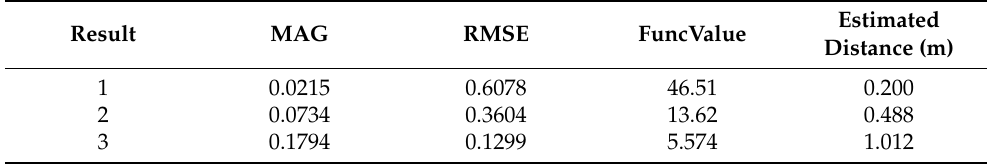
Figure 9. The two-dimensional array near-field imaging results. ( a ) Original extended source scene; ( b ) inversion results 1; ( c ) inversion results 2; ( d ) inversion results 3. Table 3. MAG and RMSE of near-field imaging results at different estimated distances of two- dimensional array.